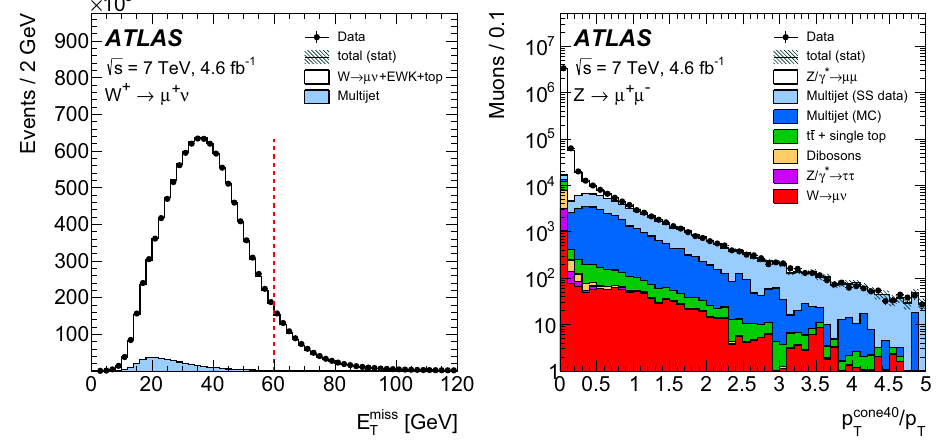
Fig. 2 Distributions used for the estimation of the multijet background in the W → μν channel ( left ) and Z /γ ∗ → μ + μ − channel ( right ). For the W → μν channel, the result of the template fit using the E miss distribution is shown. The vertical line indicates the upper boundary = 60 GeV) of the region used in the fit. The label “EWK+top” ( E miss T refers to the electroweak and top-quark background contributions esti-